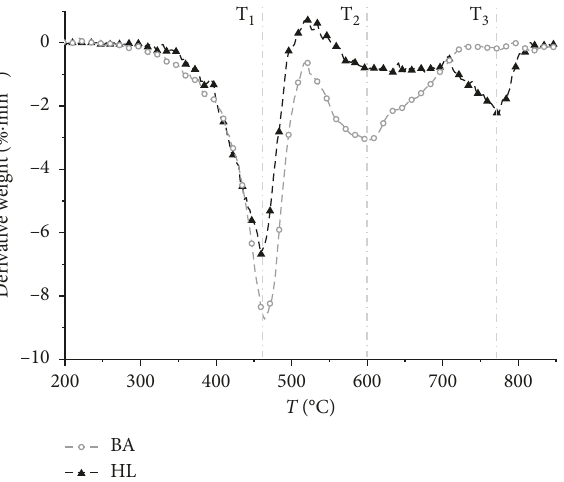
Figure 2: CO fraction curves of asphalt binder and mastics.